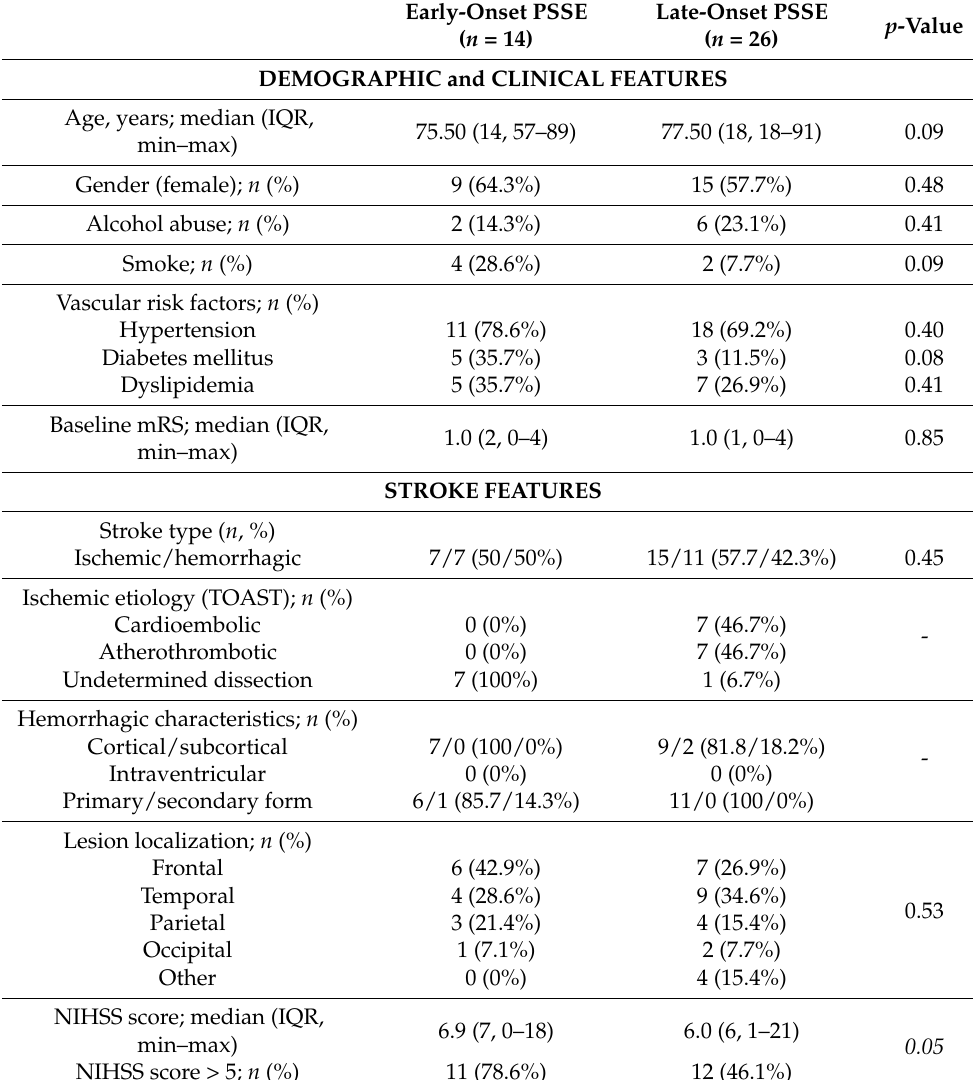
Table 2. Demographics characteristics, comorbidities, and stroke clinical features of study